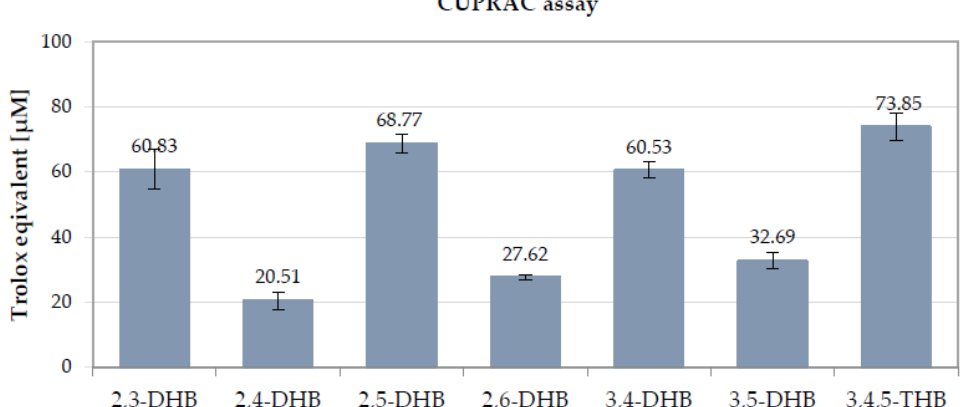
Figure 4. Comparison of the antioxidant activity of the tested hydroxybenzoic acids at a concentration of 50 μM (meth- anolic solutions), as measured by the CUPRAC assay. Mean values from three independent experiments ± SD are shown. Summarizing the results of the four antioxidant assays based on different mecha- nisms of action (DPPH • , ABTS •+ , FRAP, and CUPRAC assays), 2,3-DHB, 2,5-DHB, 3,4-DHB, and 3,4,5-THB showed the strongest antioxidant activity (Tables 2 and 3, Figures 3 and 4). The higher antioxidant activity of these DHBs can be explained by the resonance structures of their radicals [76]. In the case of DHBs with the -OH groups lo- cated in the ortho- and para- positions to one another, both oxygen atoms from the -OH groups participate in the delocalization of the electronic charge in the radical molecules. Meanwhile, the -OH substituents being in the meta- position of in the ring limits the de- localization of the charge with the participation of the second -OH [77]. 3,4,5-THB showed the highest antioxidant activity in the DPPH and CUPRAC assays; it contains the greatest number of hydroxyl (-OH) groups (three) bonded to the benzoic ring in an ortho- position to one another. It was previously shown that the antioxidant activity of phenolic compounds increases with the increasing number of hydroxyl groups substituted in the aromatic ring [39]. The same relationship was observed in the study of Sroka and Cis-